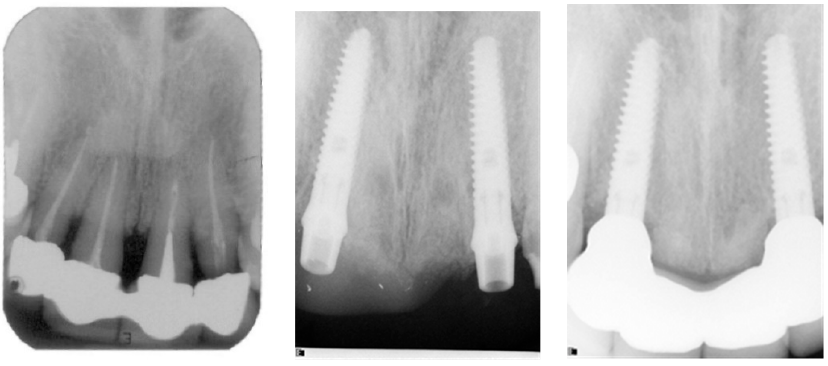
Figure 9. Radiographs taken before treatment, at transfer verification, and 40 months after bridge installation. (patient No. 29).